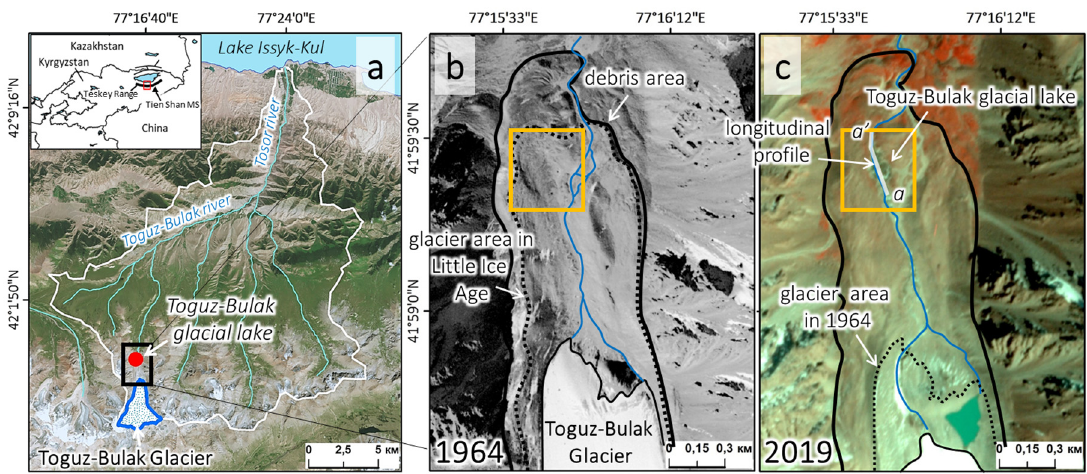
Figure 1. The study area. ( a ) The Toguz-Bulak river basin (white line) and the glacial lake investigated (red dot). Black rectangle is region of ( b ) and ( c ). ( b ) The moraine complex at the Toguz-Bulak Glacier front revealed from a Corona KH-4A image for 6 October 1964. ( c ) Same as ( b ) except from a PlanetScope image for 15 August 2019.